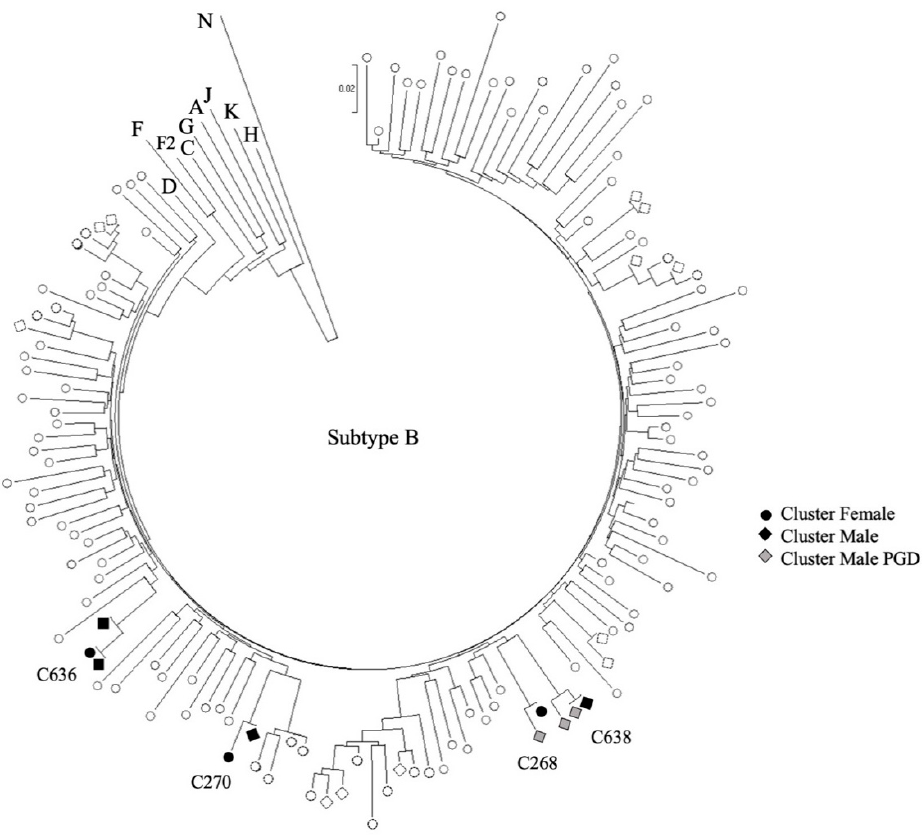
Figure 1. Phylogenetic tree of HIV-1 subtype B using a subsample of pol sequences from de-identified individuals (infected Haitians ( n = 132) in the province) from Table 1. Clustering was inferred based on bootstrap support (>97%) and short genetic distance (<0.01). PGD: Provincial genotyping database.